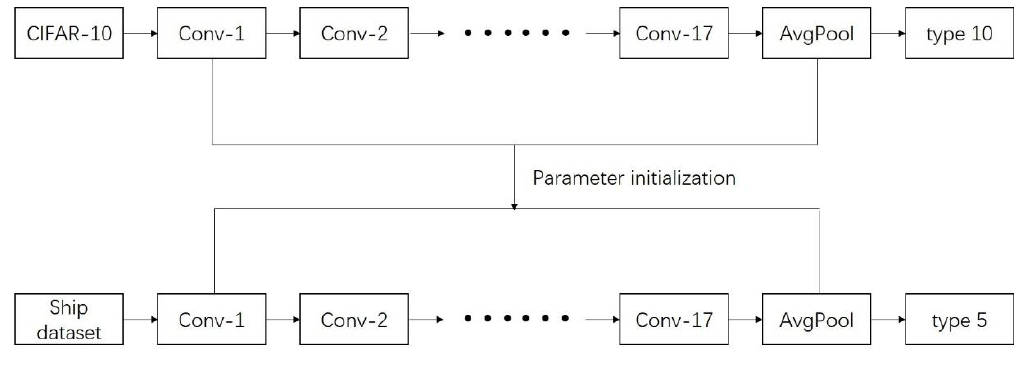
Figure 6. Transferring learning.